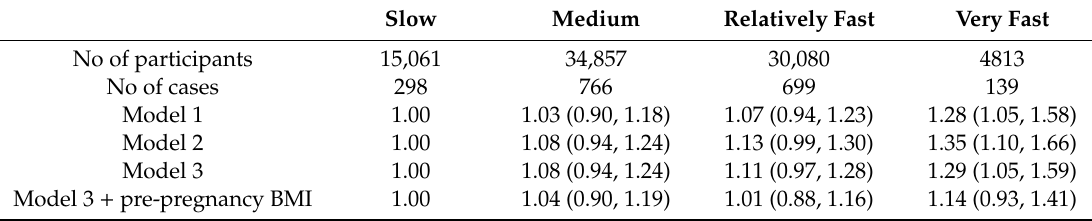
Table 2. Self-reported eating speed and risk of gestational diabetes mellitus among 84,811 women. Slow Medium Relatively Fast Very Fast No of participants 15,061 34,857 30,080 4813